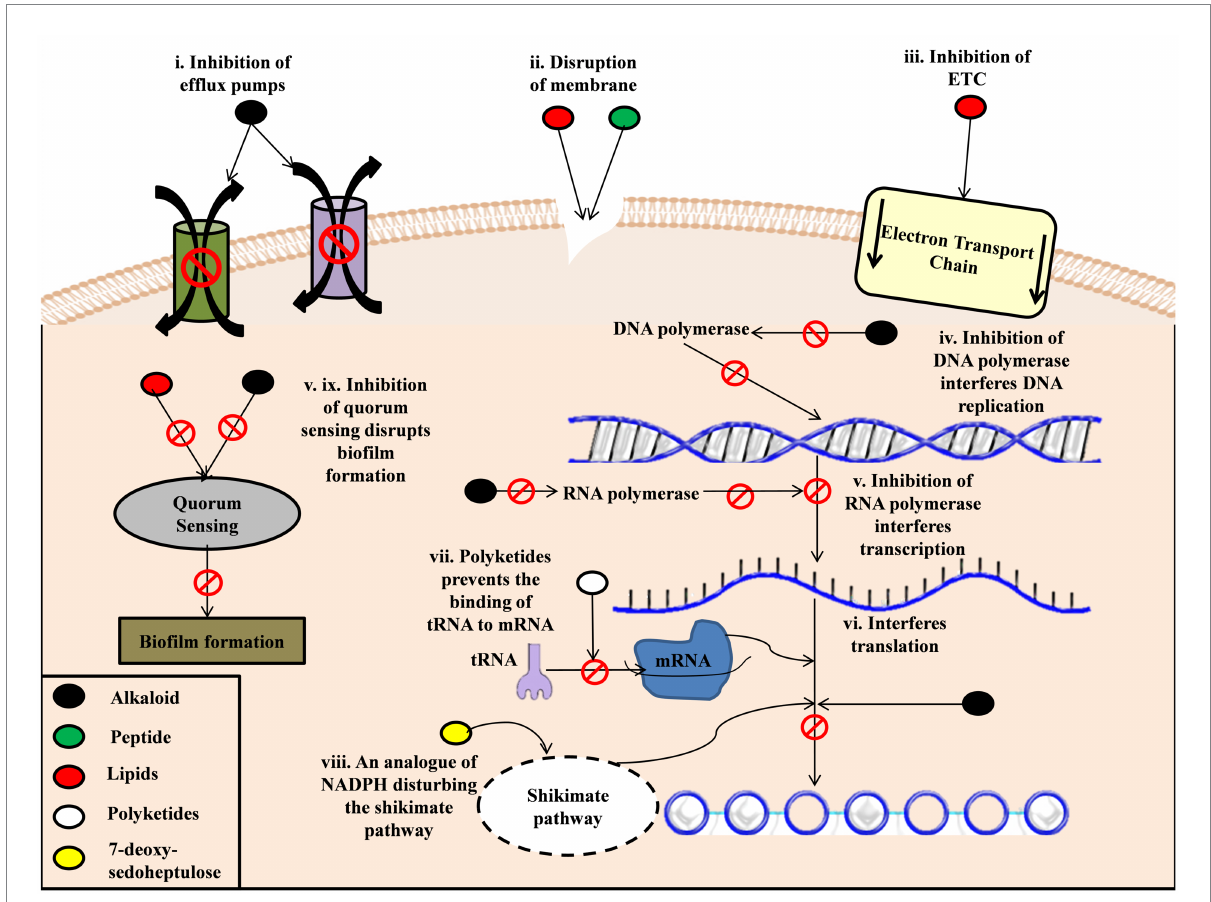
FIGURE 1 Mechanism of cyanobacterial metabolites action on bacteria. (i). Alkaloids derived from cyanobacteria inhibit the efflux pumps in bacteria (ii). Peptides and lipids of cyanobacteria disrupt the cell membrane and cause inner content leakage (iii). Lipids also inhibit the electron transport chain in bacteria disrupting the functioning of the cell (iv). Alkaloids inhibit DNA polymerase, which disrupts DNA replication (v). Alkaloids inhibit RNA polymerase, which interferes with the transcription process (vi). Alkaloids also interfere with the translation process (vii). Polyketides prevent tRNA binding to mRNA, which stops translation (iii). 7-deoxy-sedoheptulose, a sugar produced by cyanobacteria, acts as an analogue of NAPH in the Shikimate pathway, which disrupts the translation